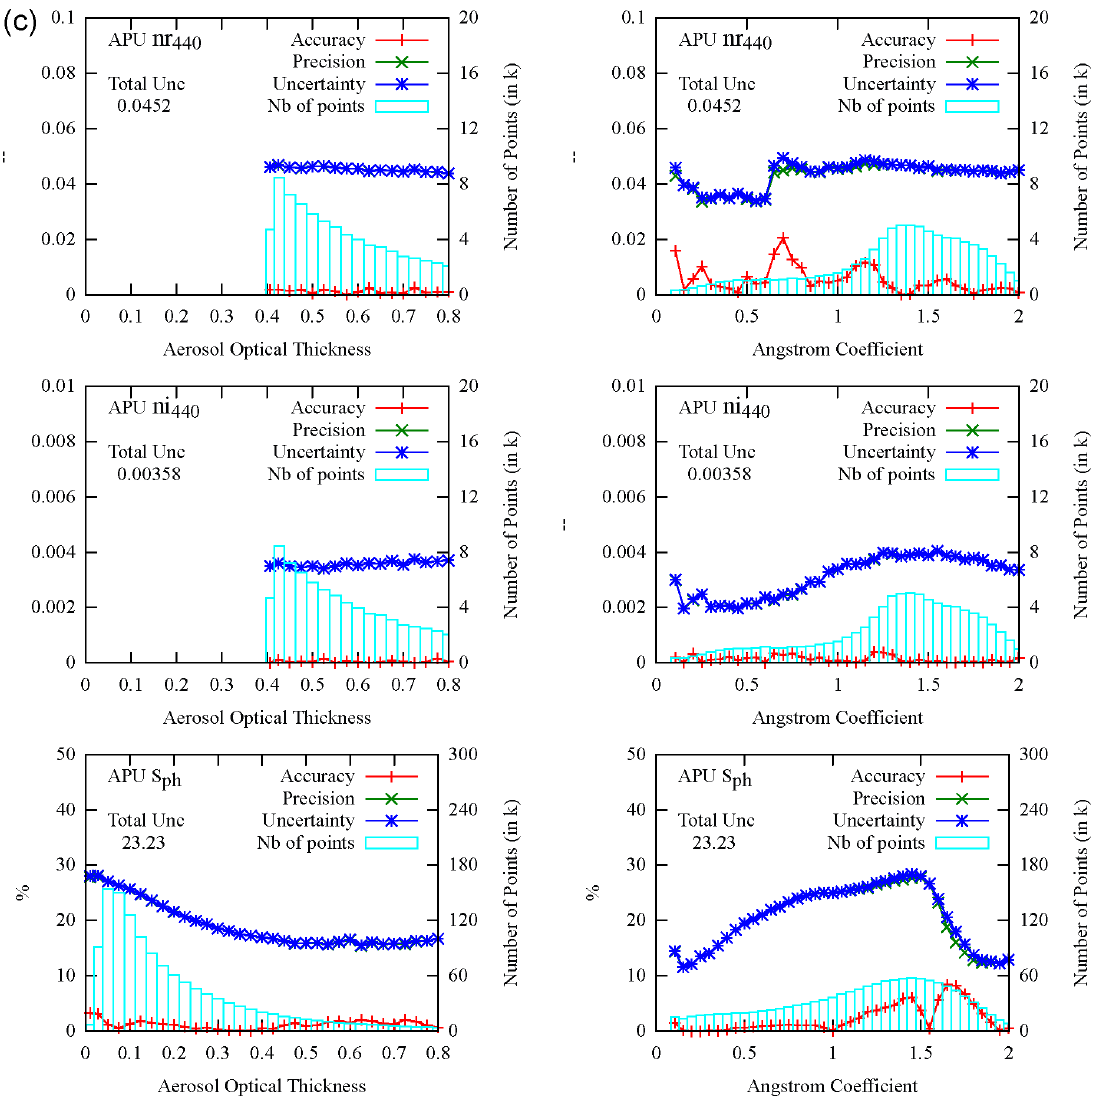
Figure 12. A , P , and U for the retrieval of each microphysical parameter (from top to bottom: the eight parameters describing the size distribution of fine and coarse modes, the two parameters for the refractive index at 440nm, and the parameter for the sphericity) versus the aerosol optical thickness at 440nm (left) and the Ångström coefficient between 440 and 870nm (right). “Total Unc” represents the total uncertainty in the microphysical